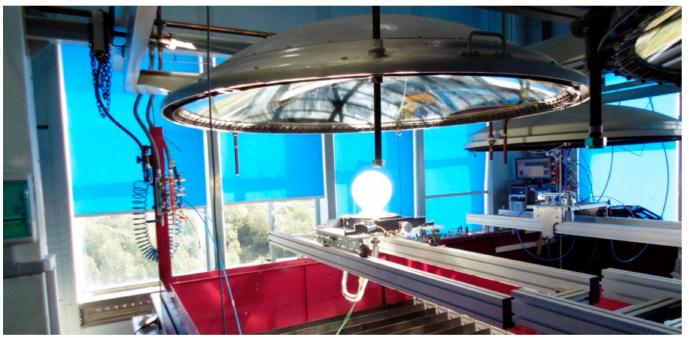
Figure 1. Scheme of the parabolic